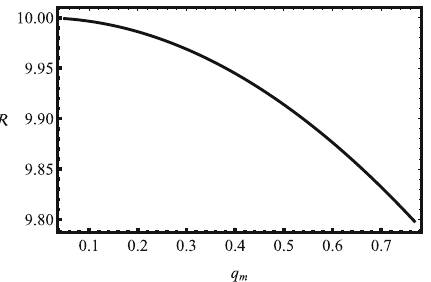
Fig. 8 Plot of the ratio R ( q m ) to illustrate the effect of magnetic field non-linearity of frequency shift. Emitter is at r e = 10 M and observer is at r o = 100